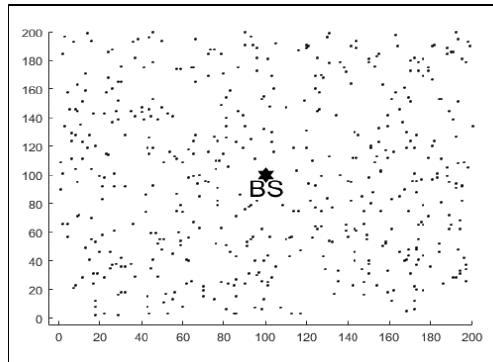
Figure 3. Nodes positioned in a 200 × 200 m 2 field.